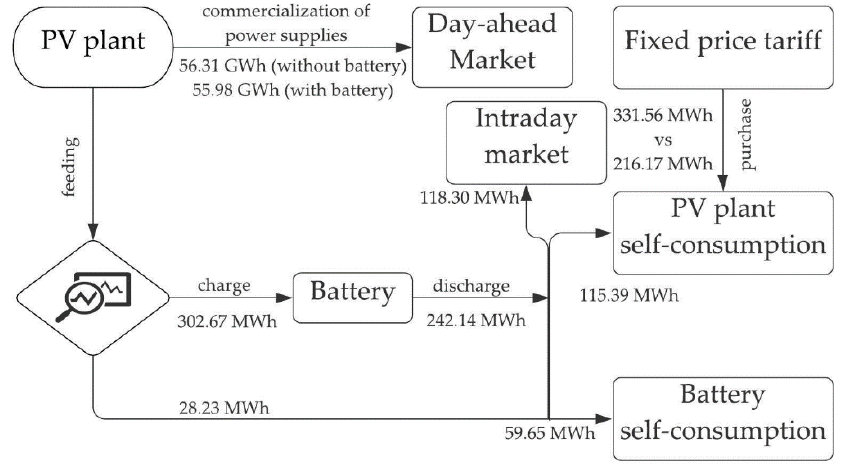
Figure 9. Control algorithm for the adopted model. Energies 2020 , 13 , x FOR PEER REVIEW